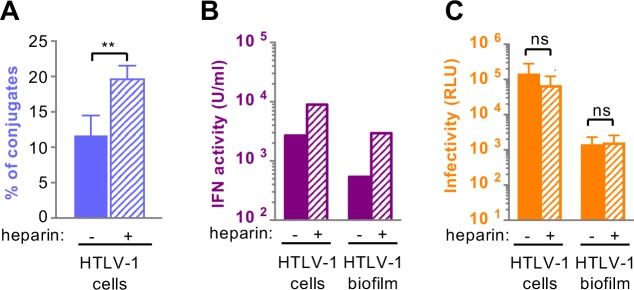
Heparin, increases pDC/infected cell contacts and pDC activation by both HTLV-infected cells and isolated HTLV biofilm-like structures.A. Quantification of the conjugates between CD123-stained pDCs and GFP-expressing HTLV-1 infected cells analyzed by imaging flow cytometry in co-cultures treated or not with heparin (50 U/ml). Results are expressed as percentages of pDC/HTLV-1 cell conjugates i.e., conjugates of, at least, one cell solely CD123+ and one cell GFP+, relative to the total number of single cells (GFP+ or CD123+) and the conjugates (mean ± SD; 3 independent experiments; n = 8000 events per condition). Asterisks indicate statistically significant differences calculated using ANOVA followed by Sidak’s multiple comparison test: ** p<0.01. B. Quantification of the effect of heparin treatment (50 U/mL) on IFN-I activity in SNs of pDCs co-cultured with HTLV-1-infected cells or HTLV-1-purified biofilm-like structures i.e., 2.9 ng as determined by p19gag ELISA (mean of triplicates results; representative of 3 independent experiments). C. Quantification of infectivity transmission levels to naïve Jurkat-LTR-Luc cells in presence or not of heparin upon co-culture with the HTLV-1-infected cells or isolated HTLV-1 biofilm-like structures (mean ± SD; 3 independent experiments with similar viral capsid levels in the isolated HTLV-1 biofilm-like structure as determined by p19gag levels). NS indicates statistically non-significant differences calculated using ANOVA followed by Sidak’s multiple comparison test.